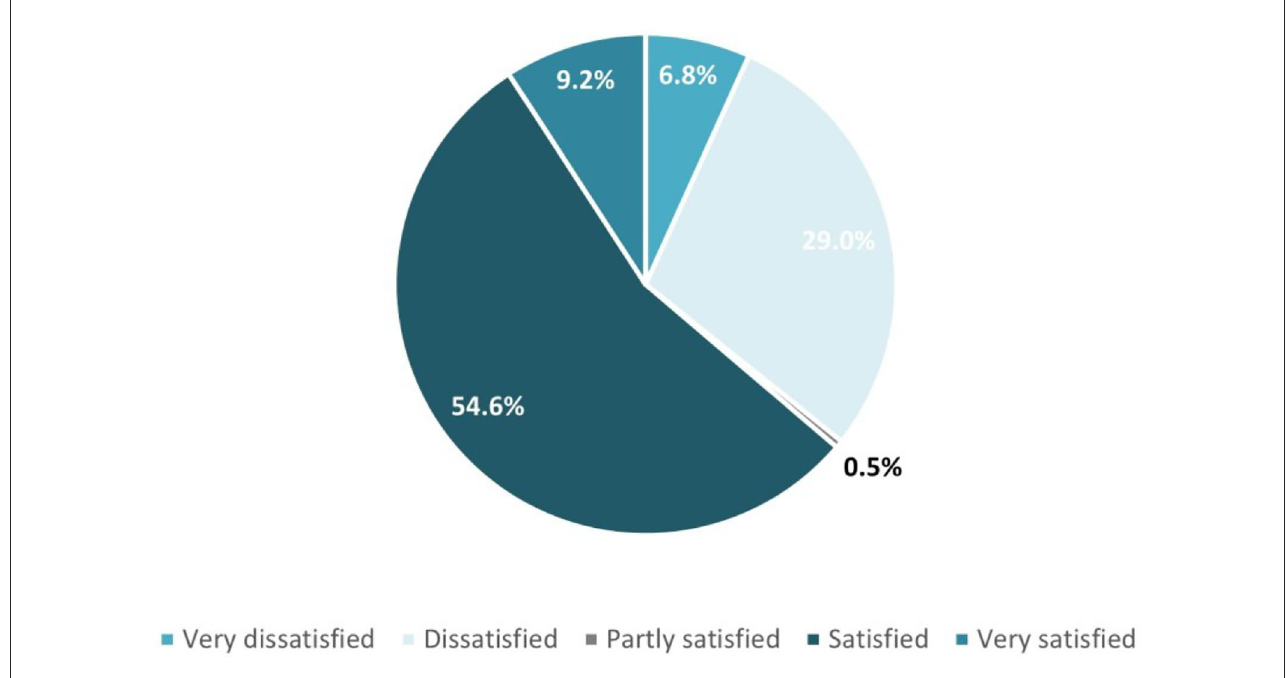
FIGURE4 Reached information satisfaction levels